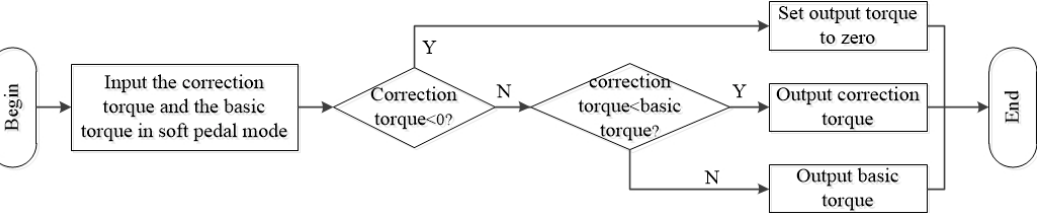
Figure 10. Flow chart of correcting torque in soft pedal drive mode.